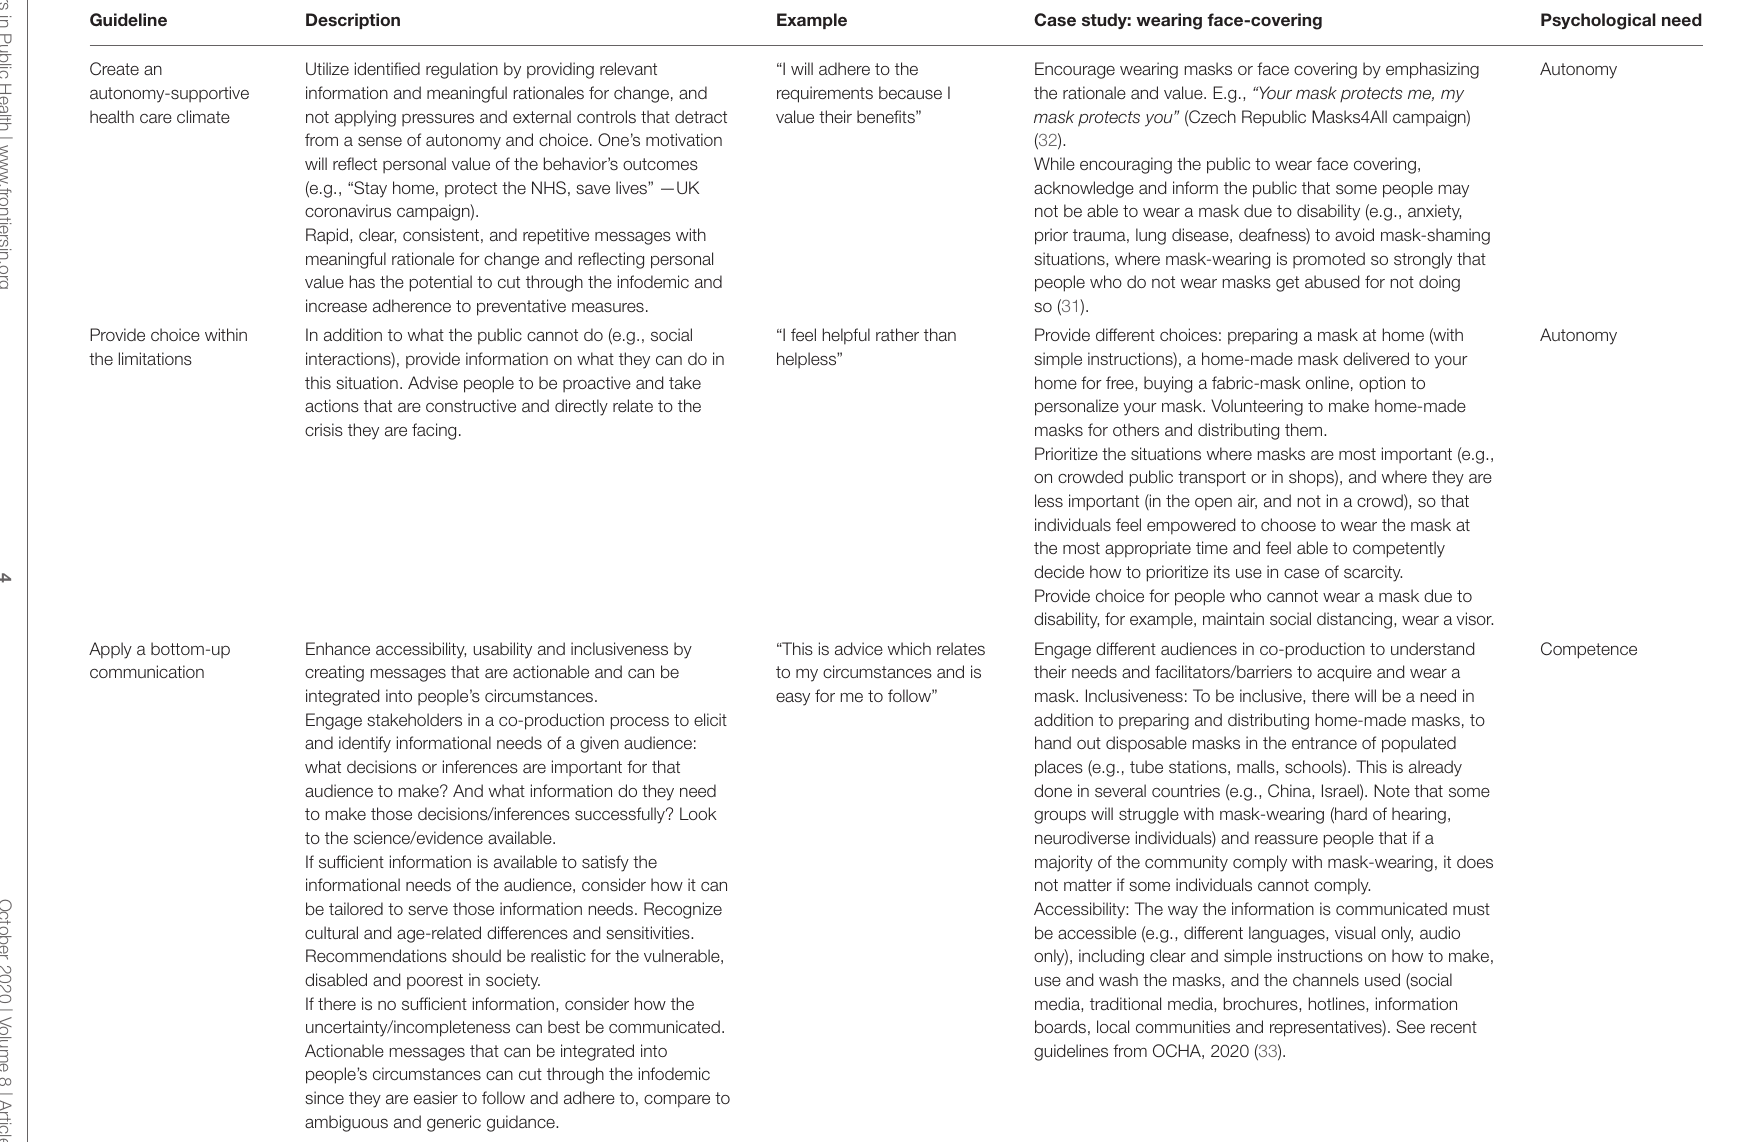
TABLE 1 | A summary of the proposed guidelines for public health communication and their application to the “face-covering” case study. Guideline